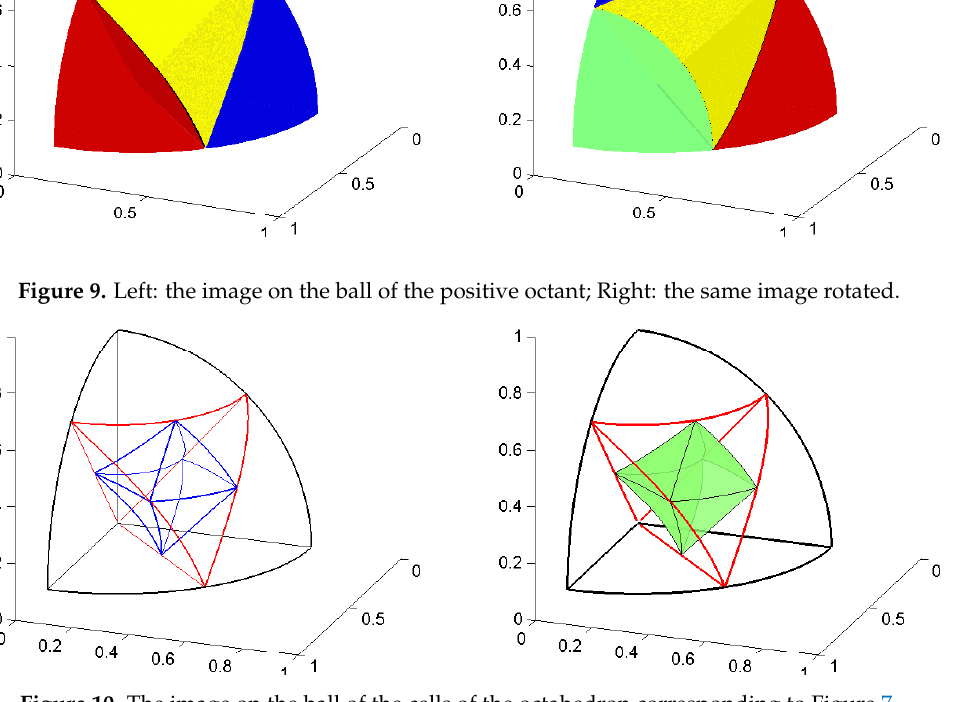
Figure 10. The image on the ball of the cells of the octahedron corresponding to Figure